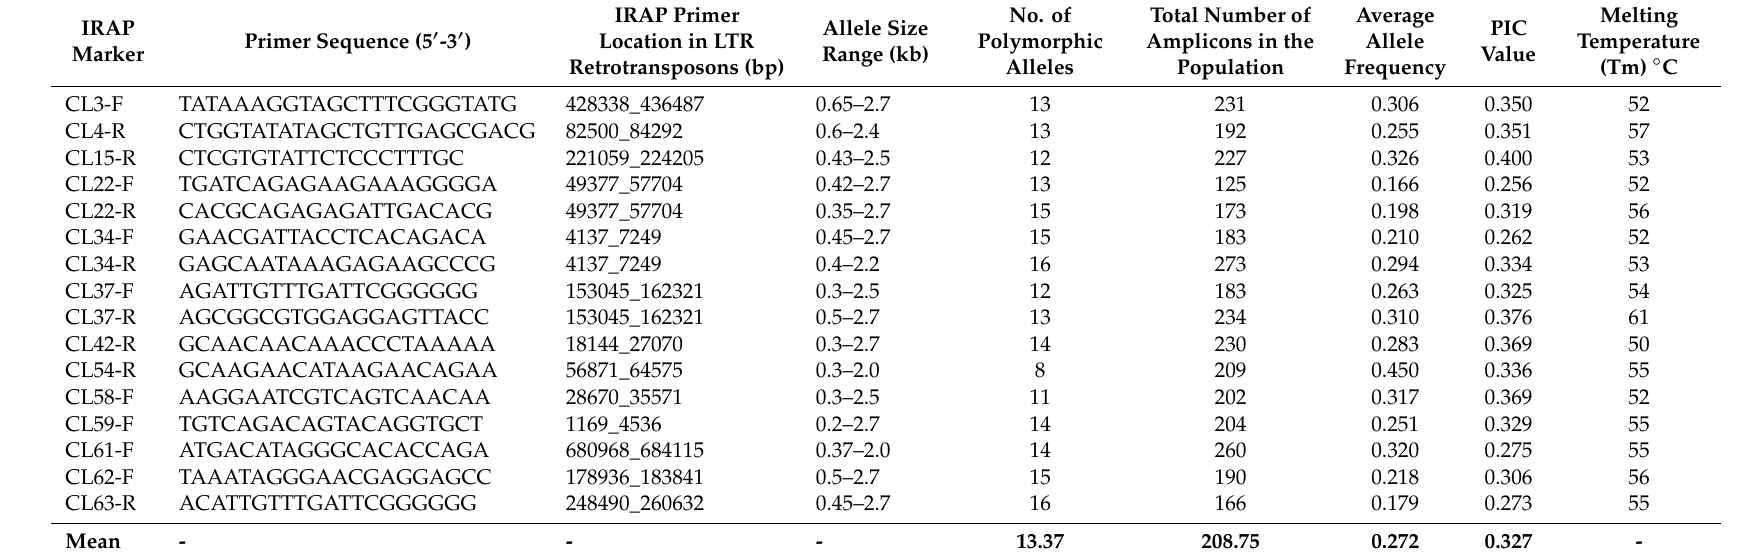
Table 2. List of inter-retrotransposon amplified polymorphism (IRAP) primers with description of amplicons used for the analysis of the genetic diversity and population structure of di ff erent Phyllostachys species (Asian